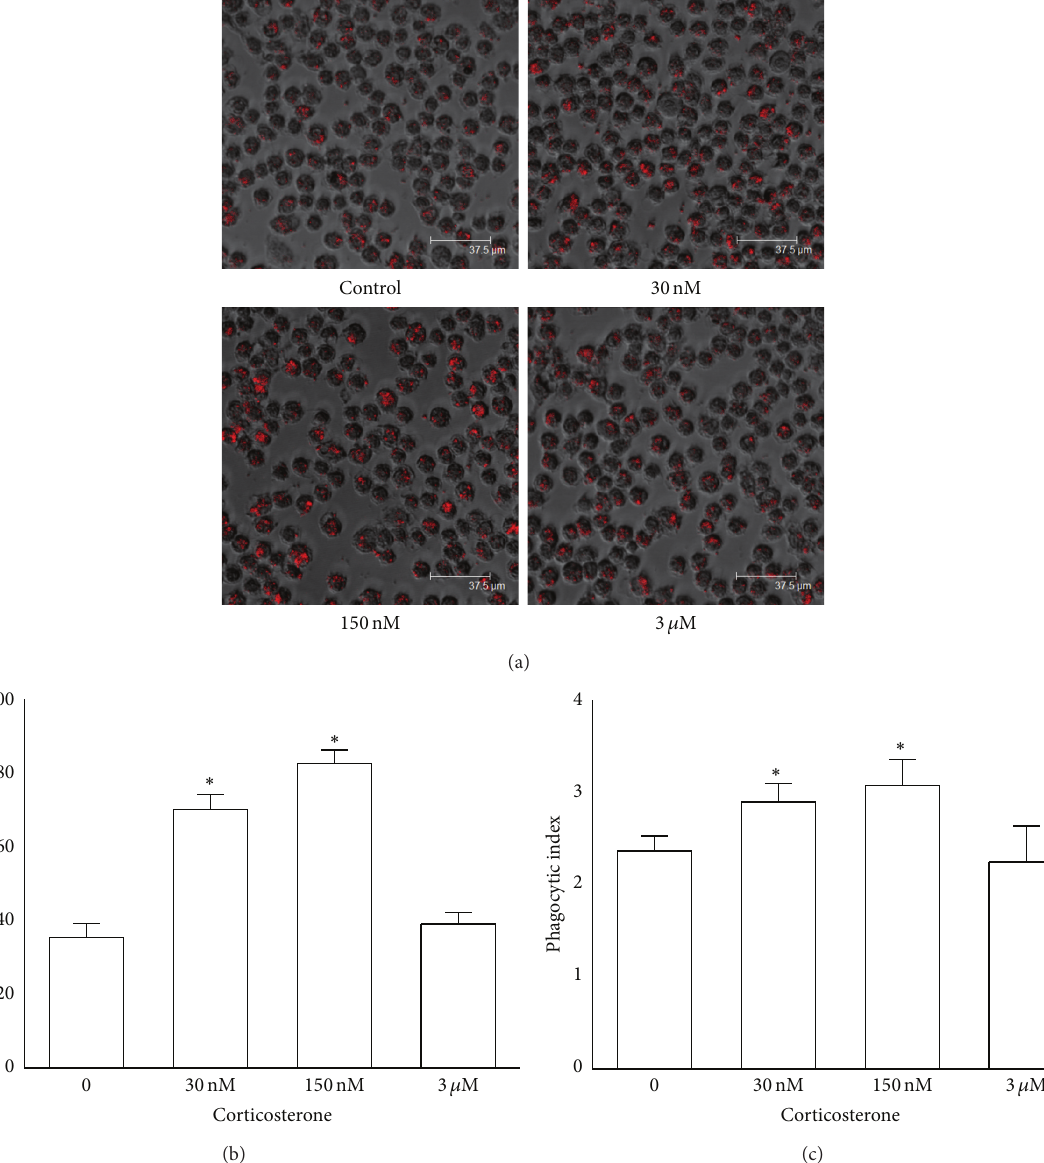
Figure 3: Effects of corticosterone on the phagocytosis of rat peritoneal macrophages. Rat peritoneal macrophages were cultured in 96-well plates and then incubated with bacteria expressing dsRed-tagged ovalbumin for 30 min at 37 ∘ C under 5% CO 2 . The macrophages were fixed using 4% paraformaldehyde. The phagocytic activity was determined by evaluating the ability to intake bacteria using confocal microscopy. (a) Rat peritoneal macrophages were treated with vehicle diluent (ethanol) as a control group. Macrophages were treated with 30nM, 150nM, and 3 𝜇 M corticosterone, respectively. Scale bar, 37.5 𝜇 m. The phagocytic activity was estimated by the phagocytic rate (b) and index (c). The results were representative of five independent experiments performed on triplicate samples. ∗ 𝑃 < 0.01 versus the control